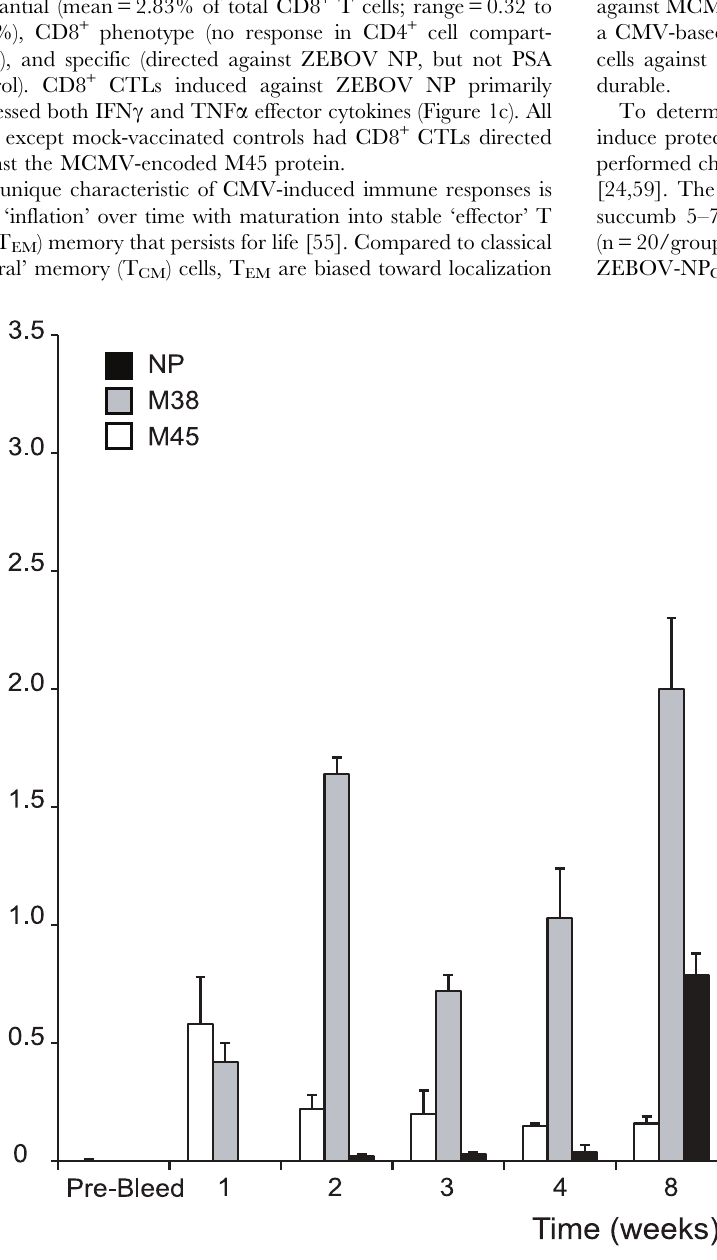
Figure 2. Kinetic analysis of CD8 + T cell response to MCMV/ZEBOV-NP CTL . 129S1/SvlmJ/Cr H2 b -restricted mice (n=14) were immunized (i.p.) with a single dose (1 6 10 5 pfu) of MCMV/ZEBOV-NP CTL (clone 5D1). At times indicated, mice were bled and peripheral T cell responses were measured in pooled blood by using ICS with a 6 hour incubation in the presence of BFA with peptides. All responses were normalized against cells stimulated in the absence of peptide. Responses are against ZEBOV NP (black), or MCMV M38 (grey) and M45 (white). Error bars show the